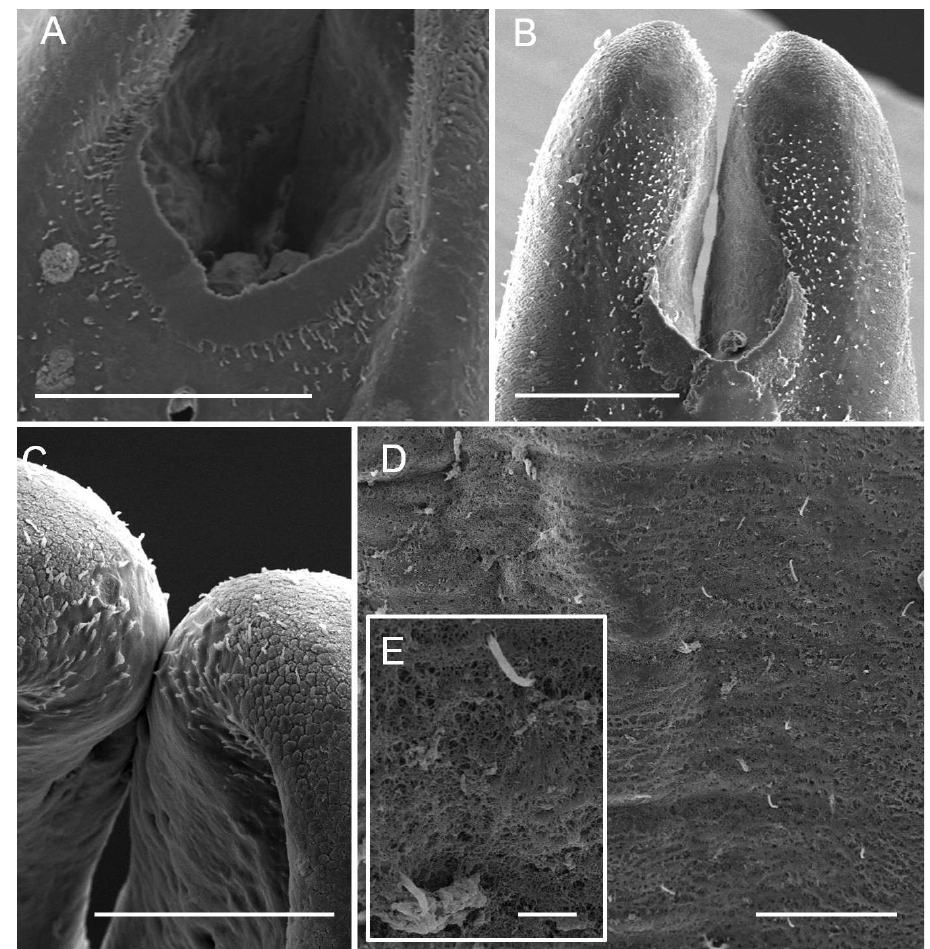
Figure 3. Detailed diagnostic characteristics of male Acutogordius taiwanensis sp. n. A Tiny bristles scat- tered anterior to postcloacal crescent B Tiny bristles scattered in concentrated groups on tail lobes C Lobe tips covered by moderately flat areoles with short spines amongst areoles D–E Short bristles scattered on the mid-body cuticle. Scale bars 200 µm ( A–B ), 100 µm ( C–D ), and 10 µm ( E